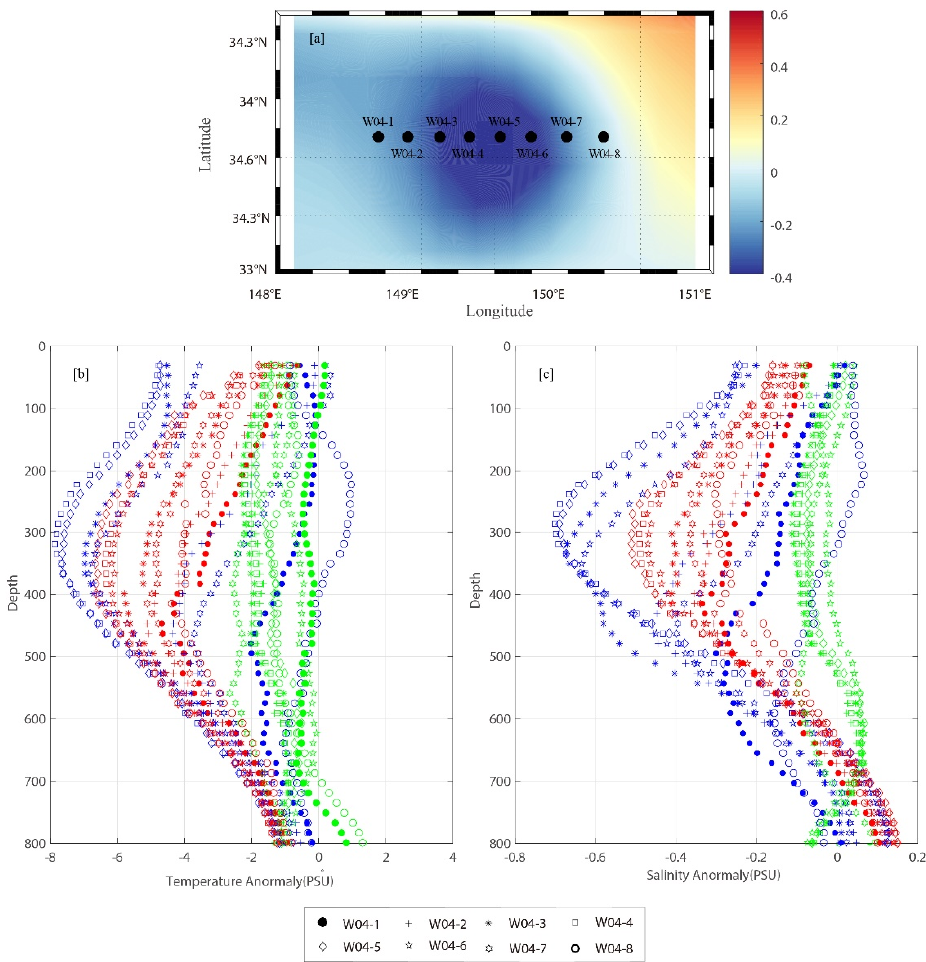
Figure 13. ( a ) Station distribution map (the color shading shows the average SLA distribution in KER during in situ period); ( b , c ) temperature anomaly and salinity anomaly profiles (Blue: observation, Green: ARMOR 3D, Red: ARGO composite eddy).